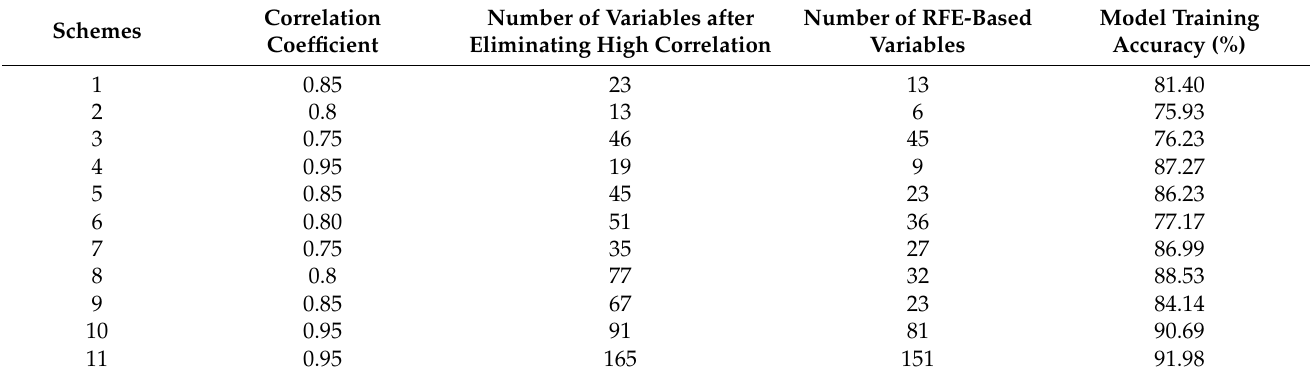
Table 5. The number of variables after high-correlation elimination and RFE-based variables selection, and the training accuracy of